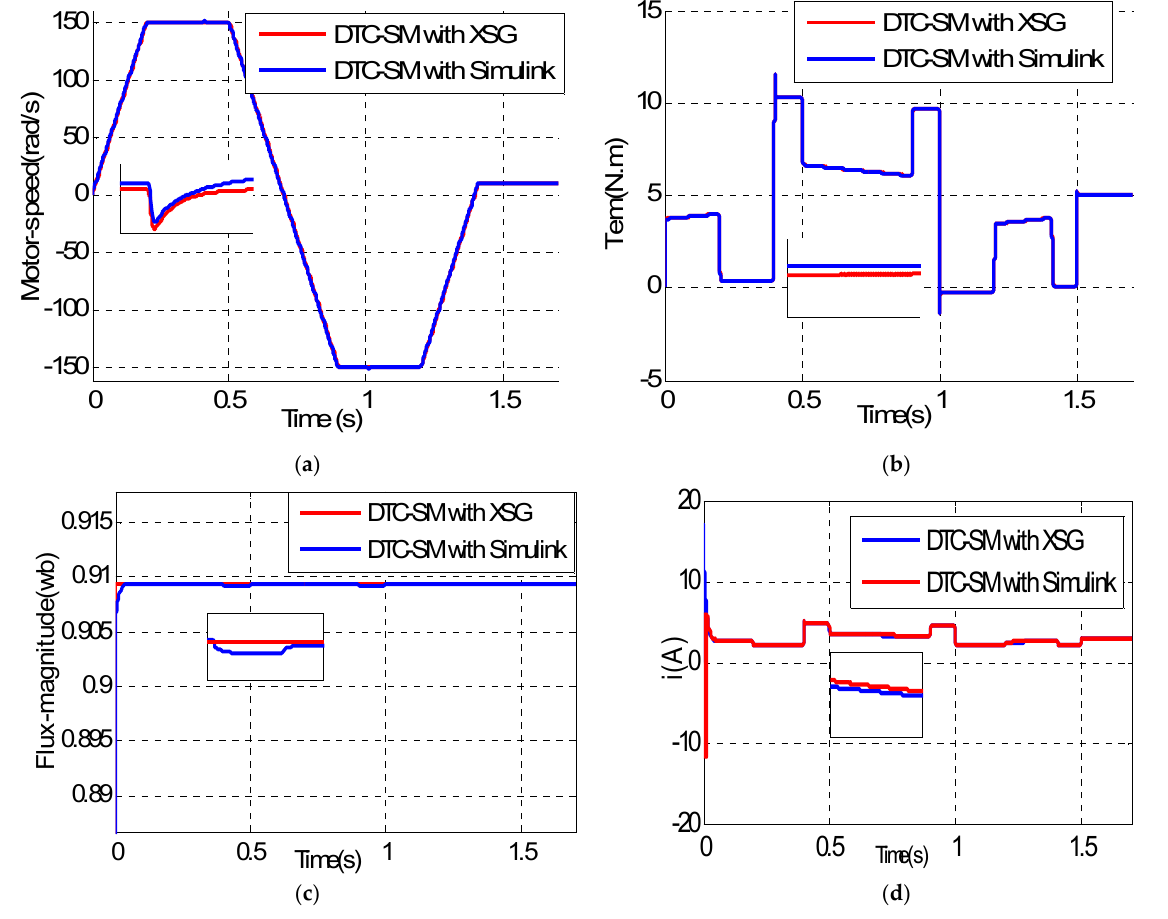
Figure 15. Evolution of the ( a ) motor speed; ( b ) electromagnetic torque; ( c ) stator flux module with both Simulink and XSG models; and ( d ) current module with XSG and Simulink.